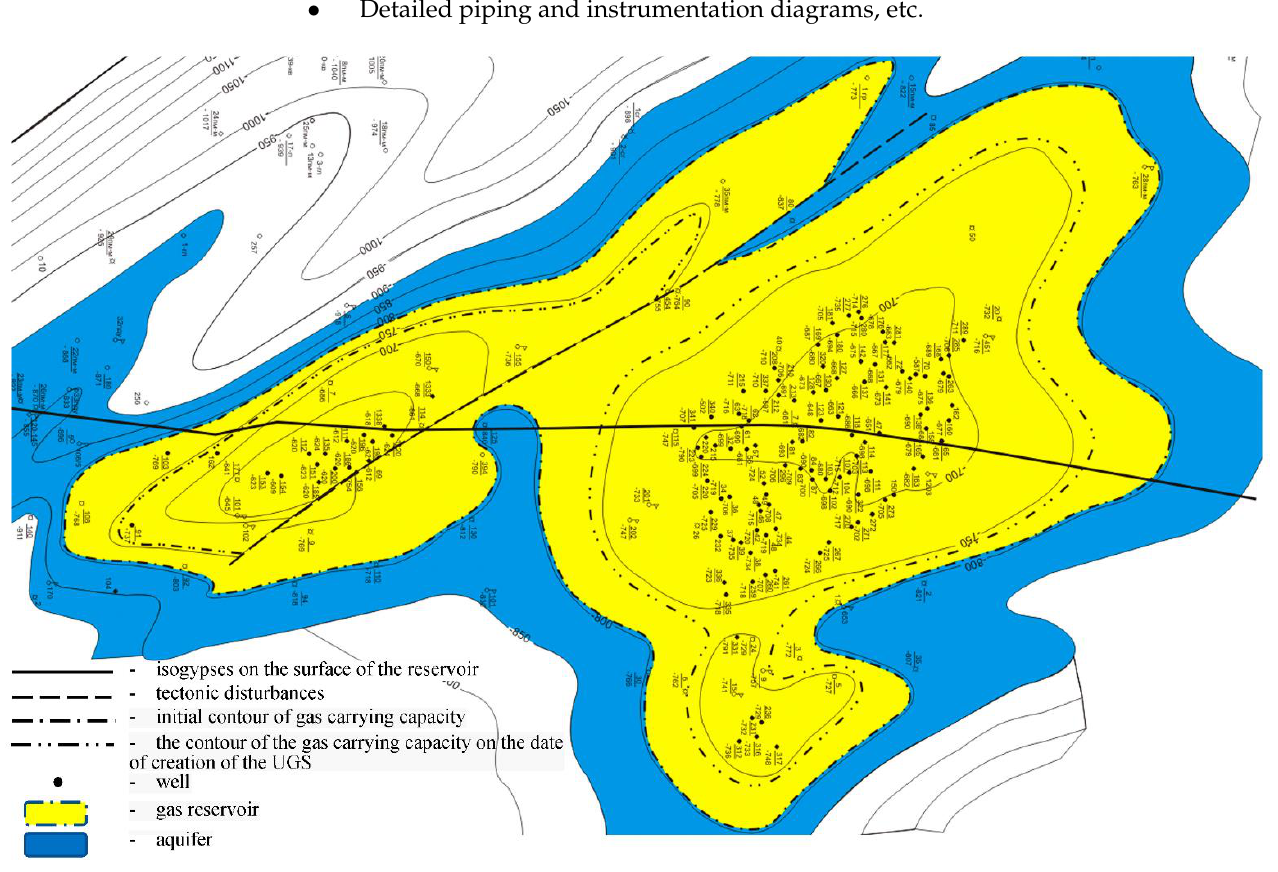
Figure 6. Structural map of the reservoir of gas storage.